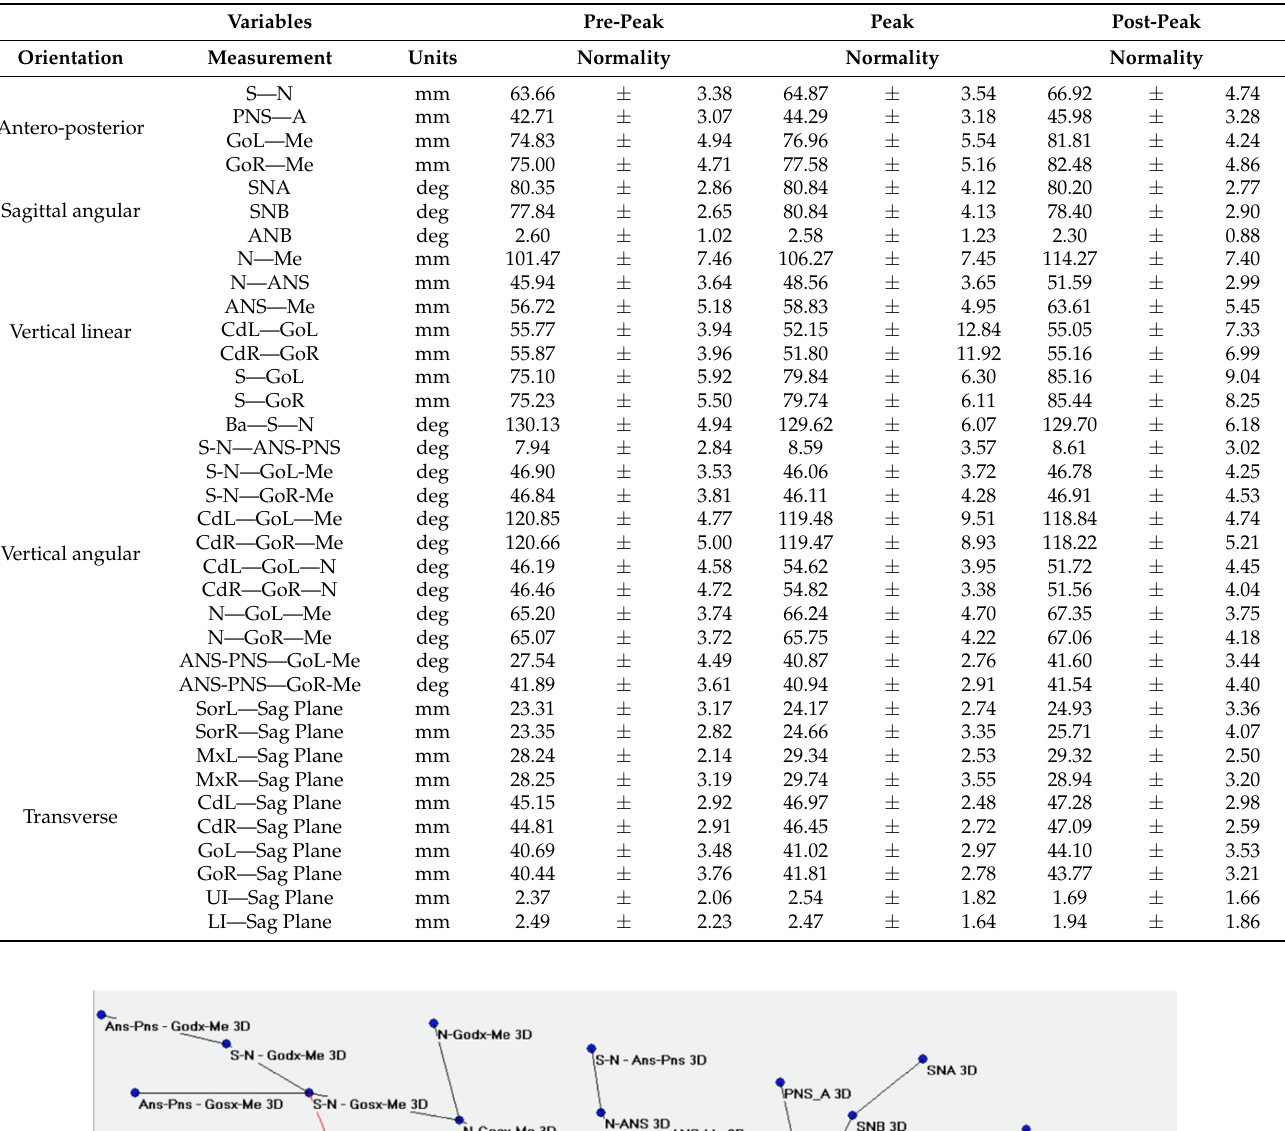
Table 5. Normality range divided into the age subgroups.